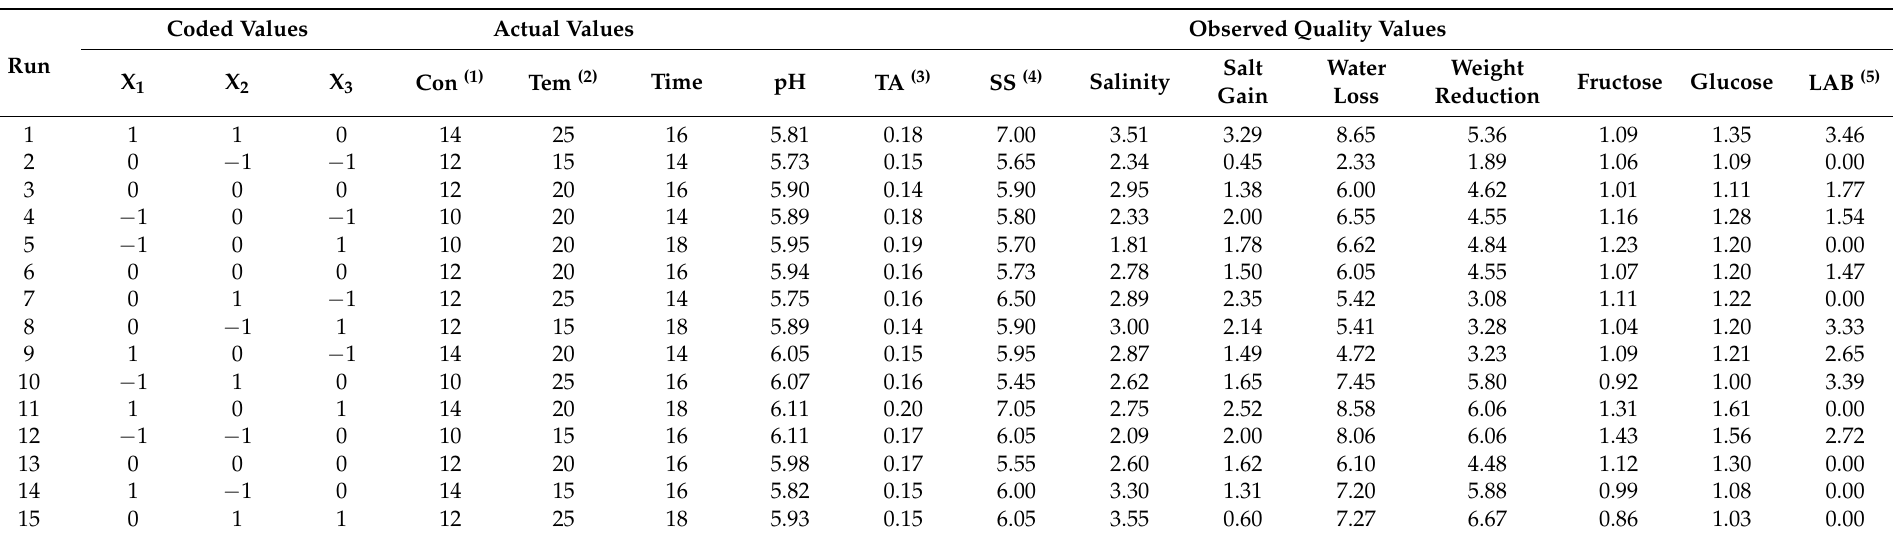
Table 2. Three-parameter BBD matrix with experimental quality values for the brining process for the